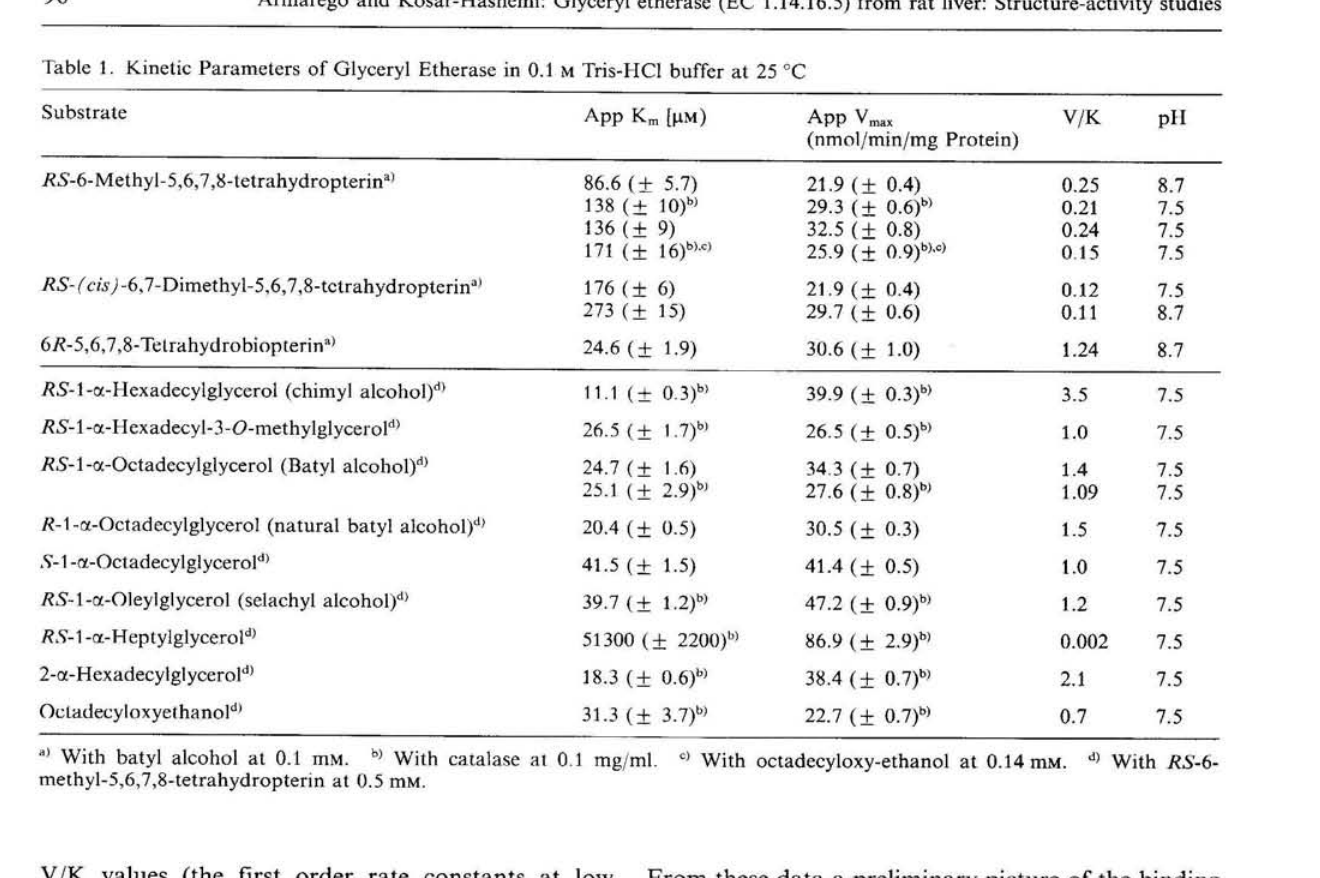
Table 1. Kinetic Parameters of Glyceryl Etherase in 0.1 M Tris-HCl buffer at 25 °C